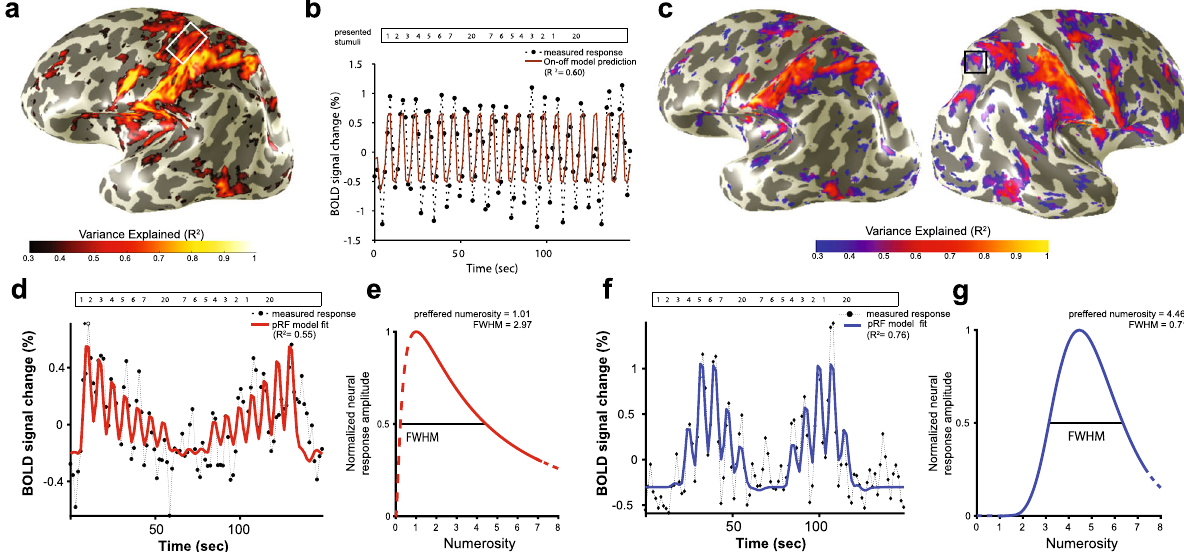
Fig. 2 Neural responses to haptic numerosity exploration. a Responses elicited by the haptic exploration of the numerosity stimuli and captured by the numerosity pRF model (variance explained). These include responses in the left motor cortex (inset). The variance explained by the numerosity model ( R 2 ) is derived across the two stimulus conditions (see Fig. 1a). b Example of the fMRI time-series from the left motor cortex illustrates similar responses throughout the task, irrespective of numerosity. The numerosities are indicated at the top of the graph. Due to the relatively slow stimulus presentation, the fMRI time-series reveals responses to each individual stimulus presentation. This pattern of responses can be well captured by a general linear model where the presence of the spheres serves as a predictor (solid line). c Goodness of fi t of numerosity-selective neural models after removal of cortical locations where the general motor predictions do not differ from numerosity selective response predictions (see methods). d , f Two samples of fMRI time courses from sites in the right posterior parietal cortex (black box in c ). The two sites show distinct responses to different haptic numerosities: d the largest response amplitude occurs at low numerosities; f the largest response occurs at higher numerosities. The numerosity pRF model ’ s predictions (solid lines) capture these different responses as different numerosity selectivity parameters. e , g The pRF model summarizes the neural responses using a logarithmic Gaussian tuning function with two parameters: preferred numerosity and tuning width, de fi ned by the full width at half maximum (FWHM). Both cortical locations respond strongly to the stimulus manipulation but with different preferred